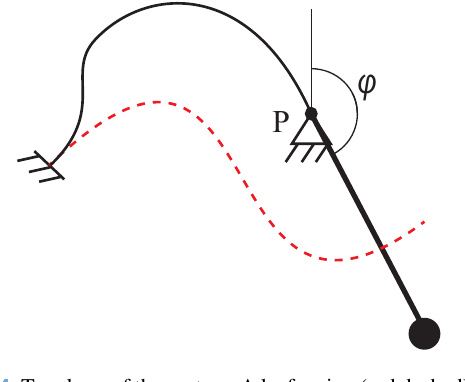
Figure 4. Topology of the system: A leaf spring (red dashed) is pre- stressed (black) by connecting one endpoint with a rigid pendulum, while the other end of the spring is clamped.